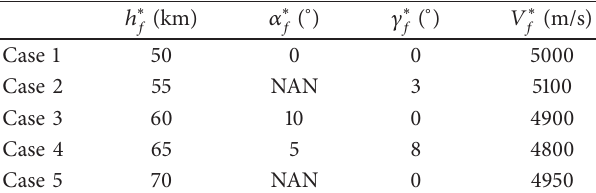
Table 3: Terminal constraints.